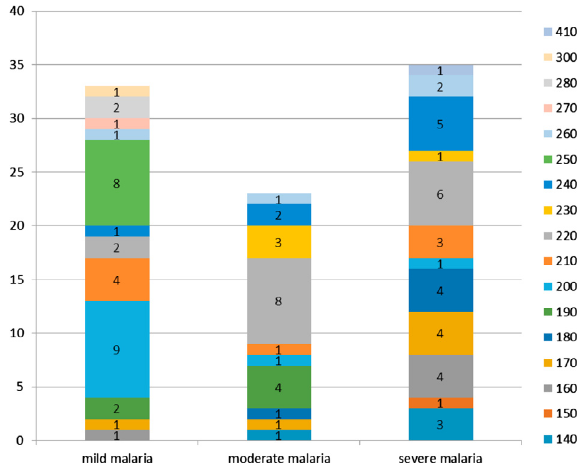
Figure 2. K1 allele distribution according to malaria clinical